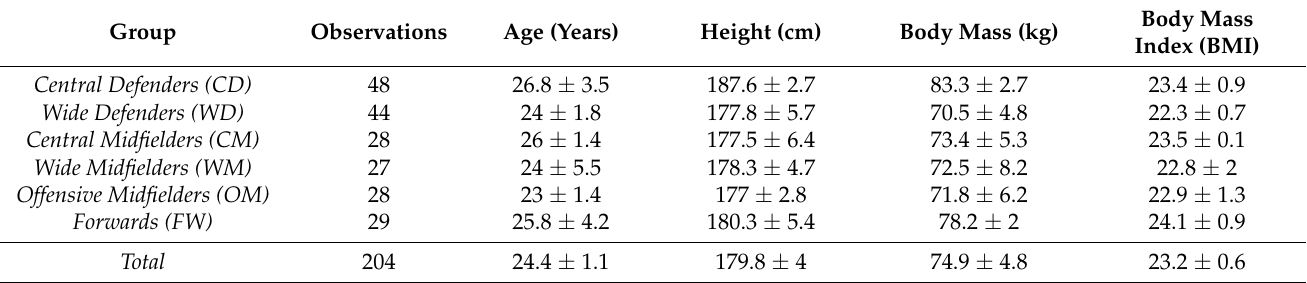
Table 1. Characteristics of the